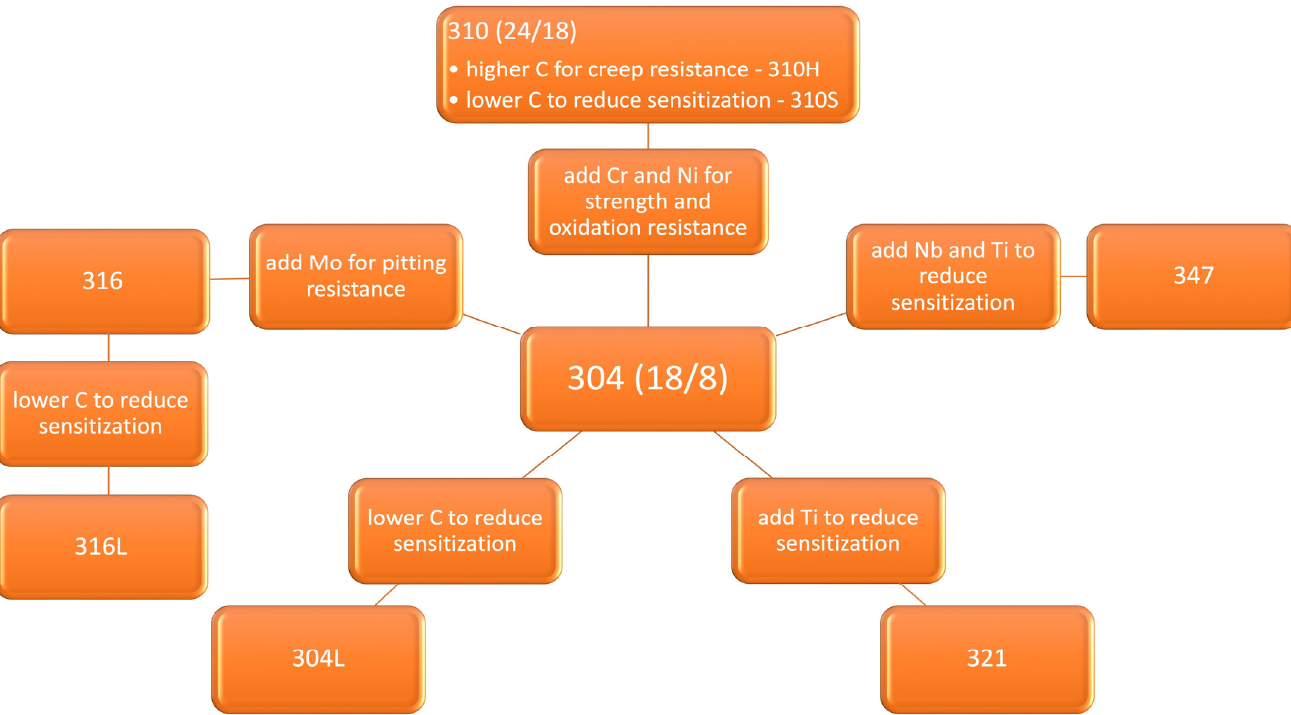
Figure 2. Compositional changes of 18/8 austenitic stainless steel to improve performance [134,135].